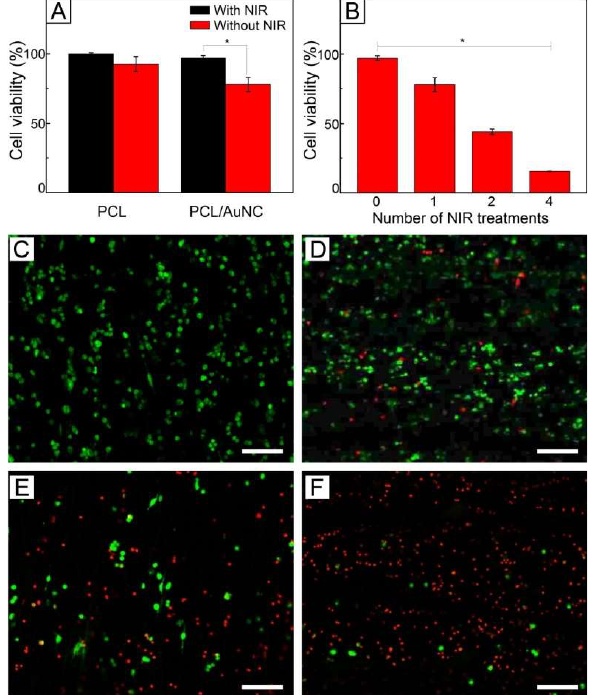
Figure 5. ( A ) Viability of SK-BR-3 cells treated with plain PCL and AuNC-loaded PCL fibers without and with NIR irradiation (1 W/cm 2 , 808 nm). ( B ) Viability of SK-BR-3 cells treated with AuNC-loaded PCL fibers under on–off switching of NIR light irradiation (1 W/cm 2 , 808 nm). * indicates p < 0.01. ( C – F ) CLS micrographs showing live (green) and dead (red) SK-BR-3 cells treated with AuNC-loaded PCL fibers under different numbers of cycles of 1 W/cm 2 NIR light irradiation: ( C ) Zero, ( D ) one, ( E ) two, and ( F ) four cycles. The scale bars are 100 μm.